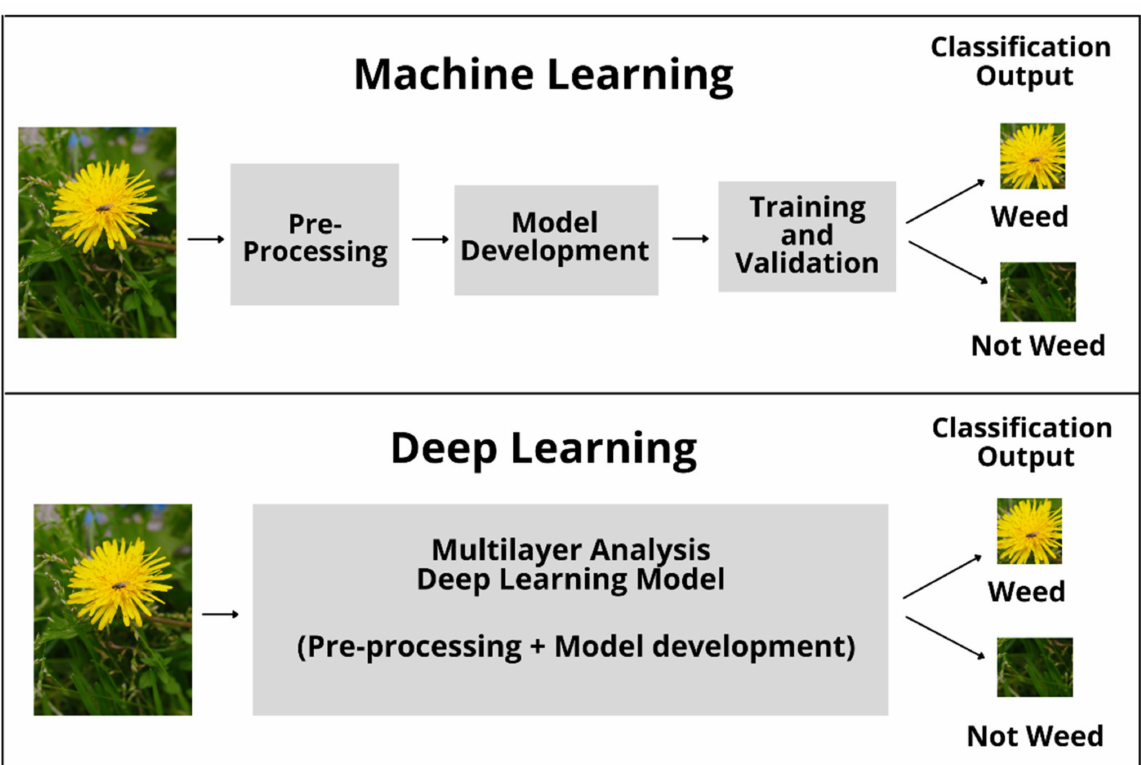
Figure 3. The differences in how deep learning and machine learning techniques